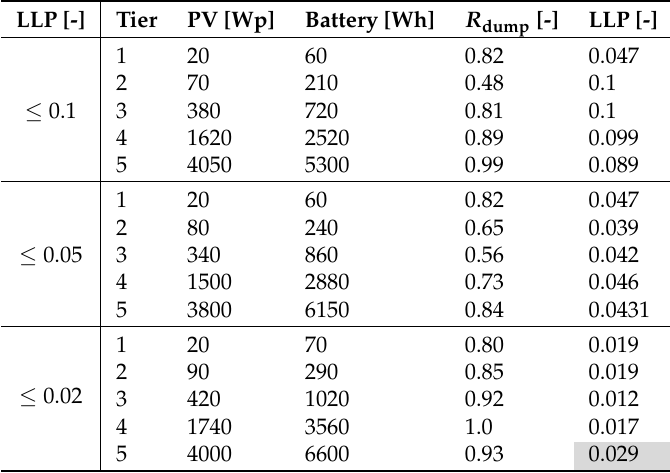
Table 3. Optimal SHS sizes that satisfy the different LLP criteria, along with the performance of these system sizes on the system metrics. Adapted from [9].